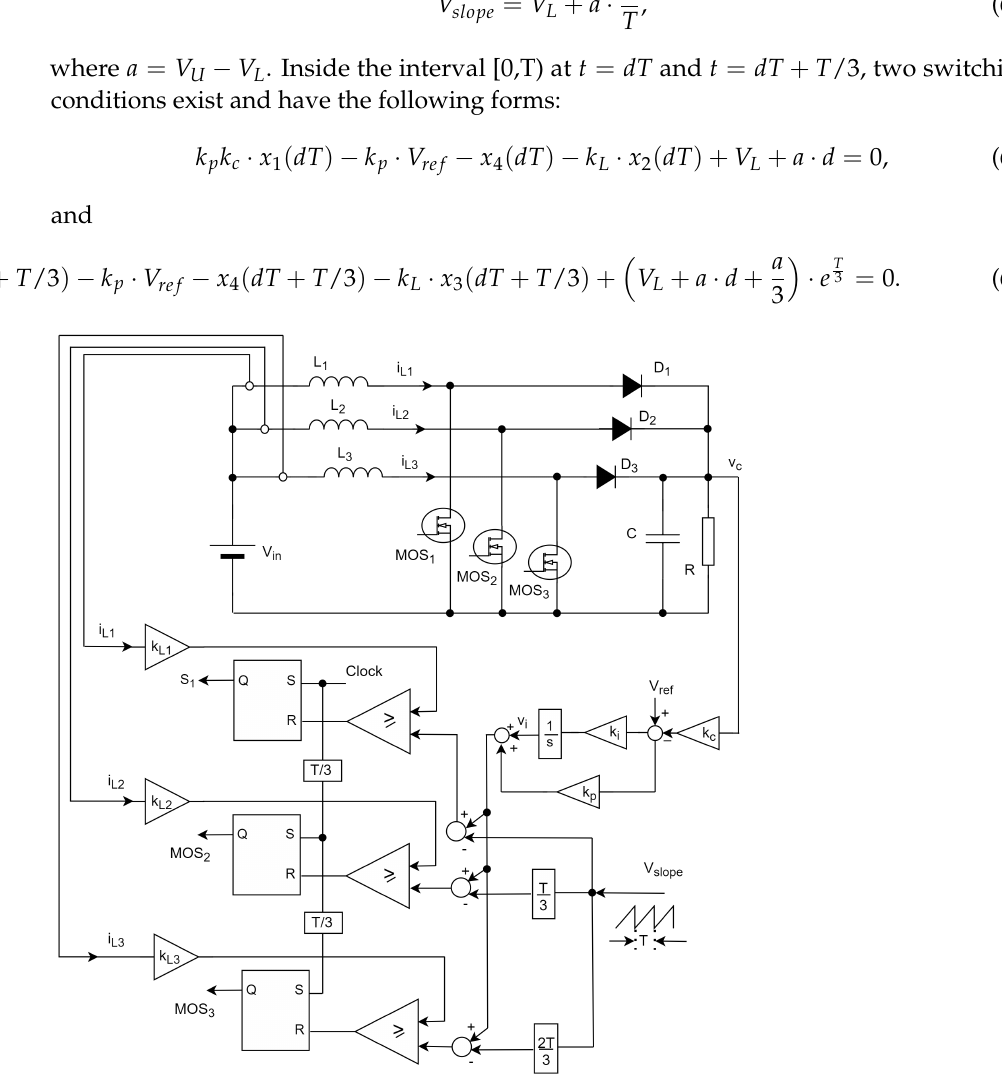
Figure 12. Interleaved boost converter with V in = 14 V, V ref = 2.4 V, L 1 = L 2 = L 3 = L = 560 µ H, C = 300 µ F, R = 1.5 Ω –2.5 Ω , T = 0.00001 s, k i = 50 , k c = 0.1, k p = 0.5, k L 1 = k L 2 = k L 3 = k L =